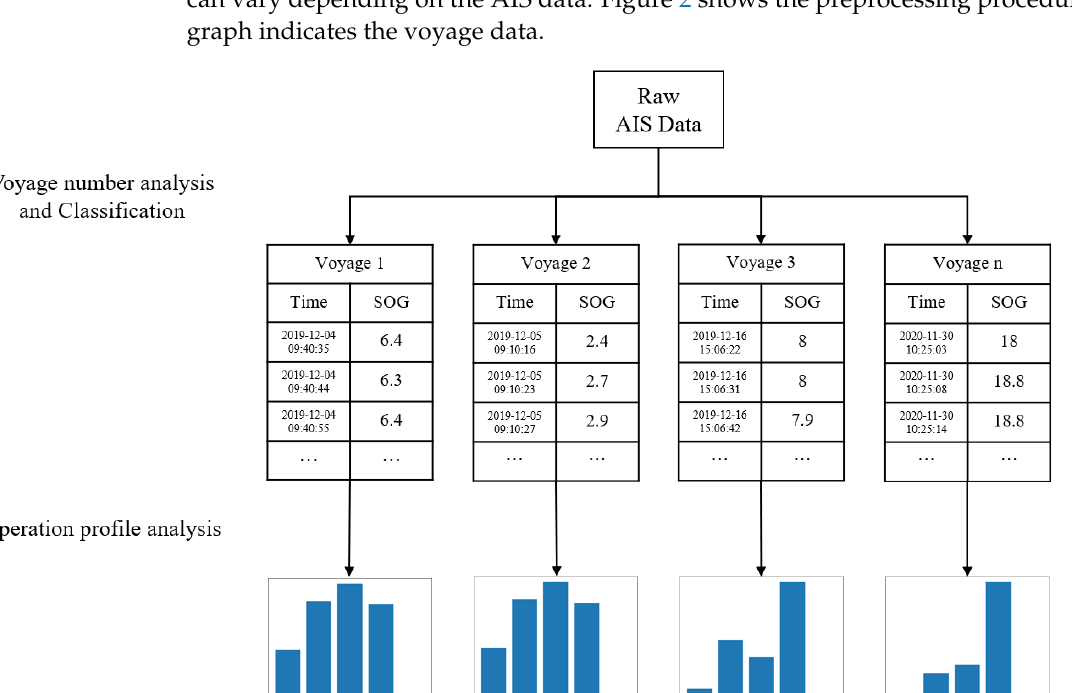
Figure 3. An example of preprocessed data. 3. K-means Clustering Algorithm The K-means clustering algorithm [18] is an unsupervised learning algorithm for clustering data. The K-means clustering algorithm is used in a variety of fields such as image analysis, pattern recognition, data mining, and bioinformatics. The K-means clus- tering algorithm can also be applied to a ship’s operation. For example, Zheng et al. [19] used a K-means clustering algorithm to analyze the characteristics of vessel traffic flow data. Affandi and Sunarmo [20] used a K-means clustering algorithm to define spatial